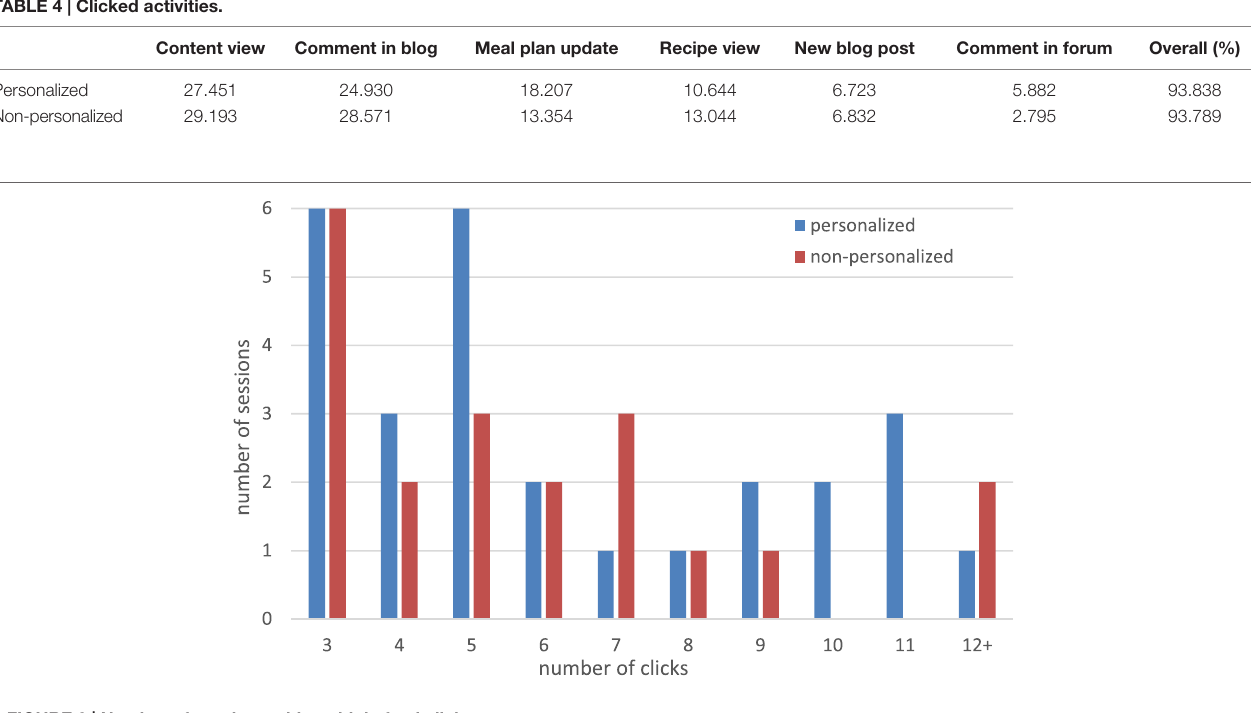
FigUre 3 | number of sessions with multiple feed clicks